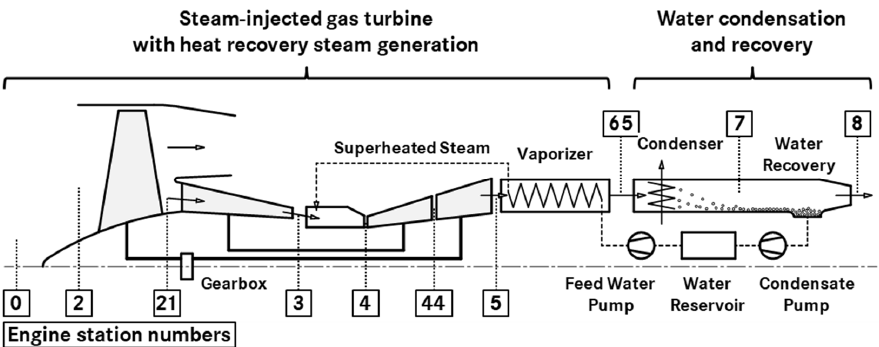
Figure 1. Basic schematic of the WET concept in a half-side arrangement supplemented with international engine station nomenclature [9].